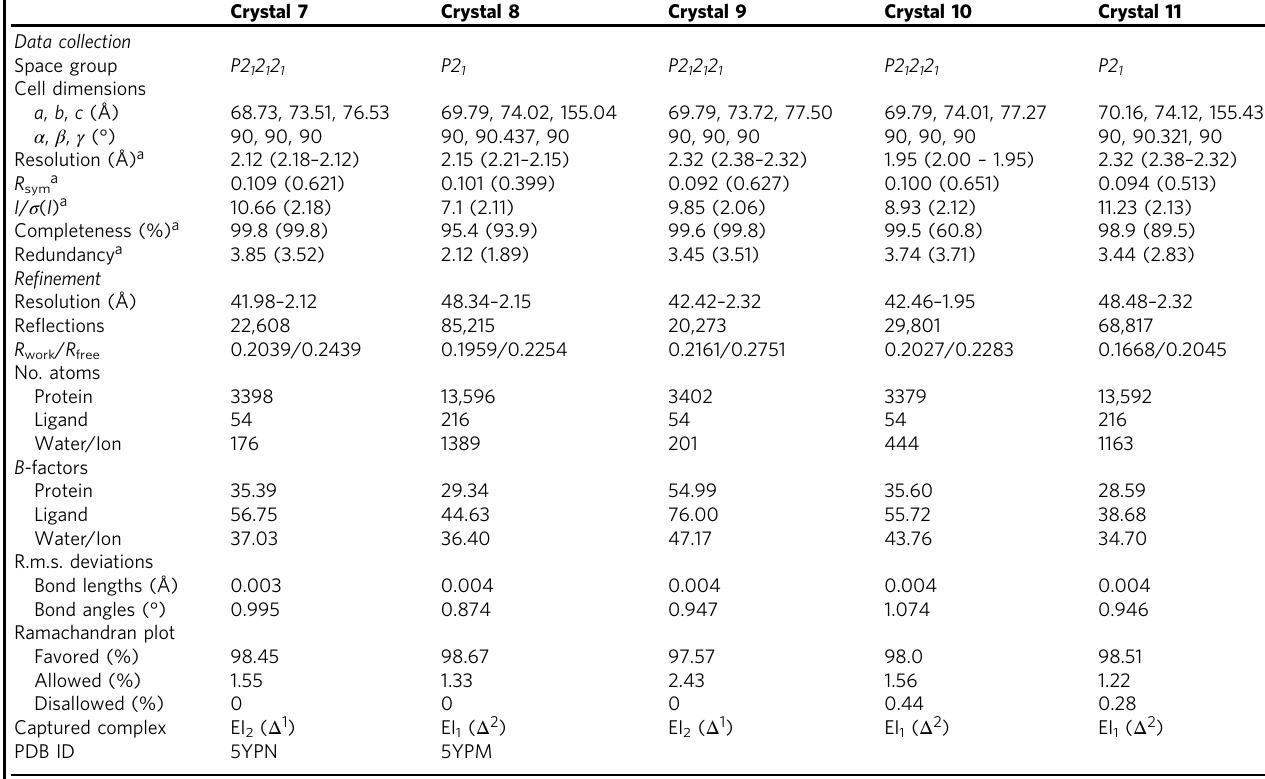
Table 2 Crystallographic data collection and re fi nement statistics of NDM-1 in complex with hydrolyzed